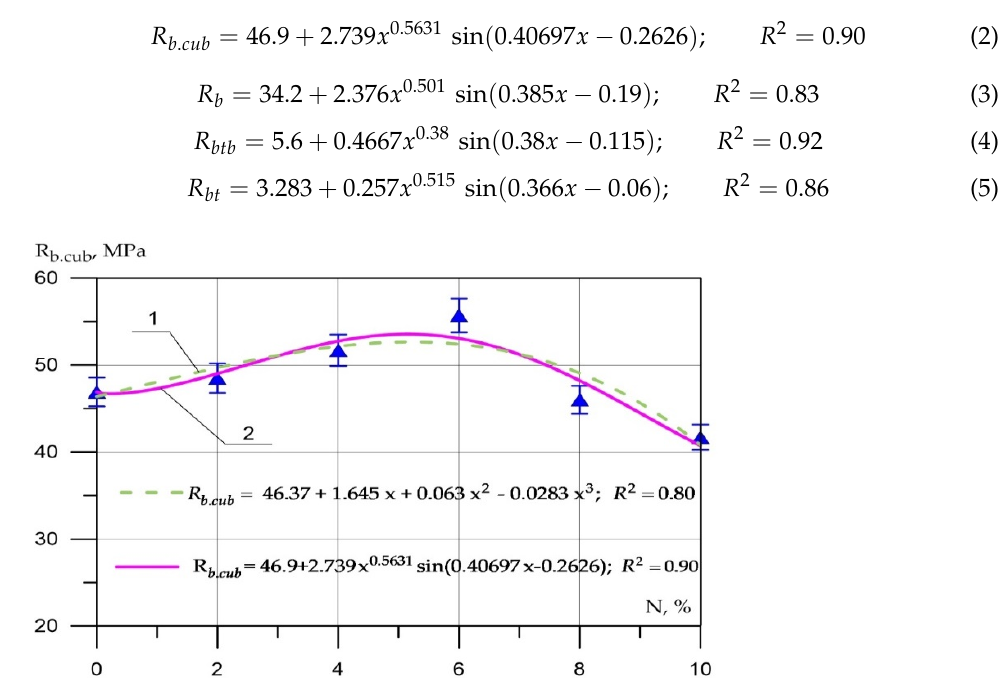
Figure 8. Results of experimental studies of the effect of dosage of rice straw biochar on compressive strength: 1—polynomial of the 3rd degree; 2—function (1).